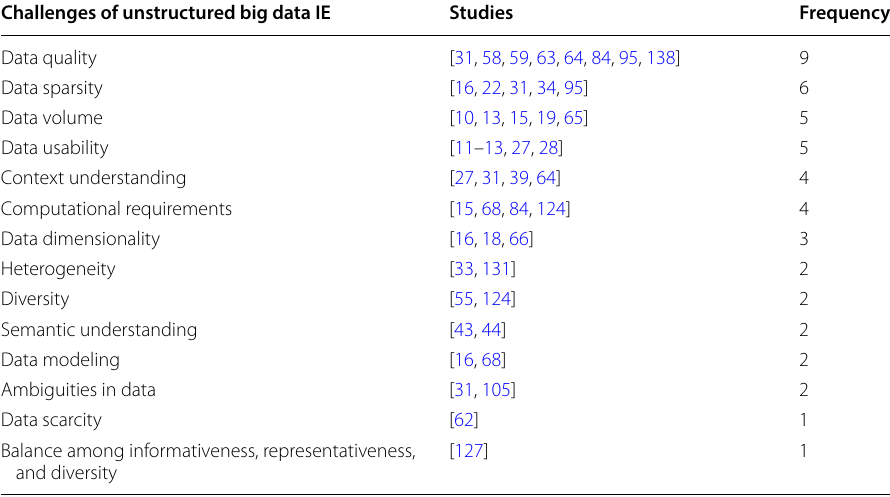
Table 14 Independent challenges identified from selected studies Challenges of unstructured big data